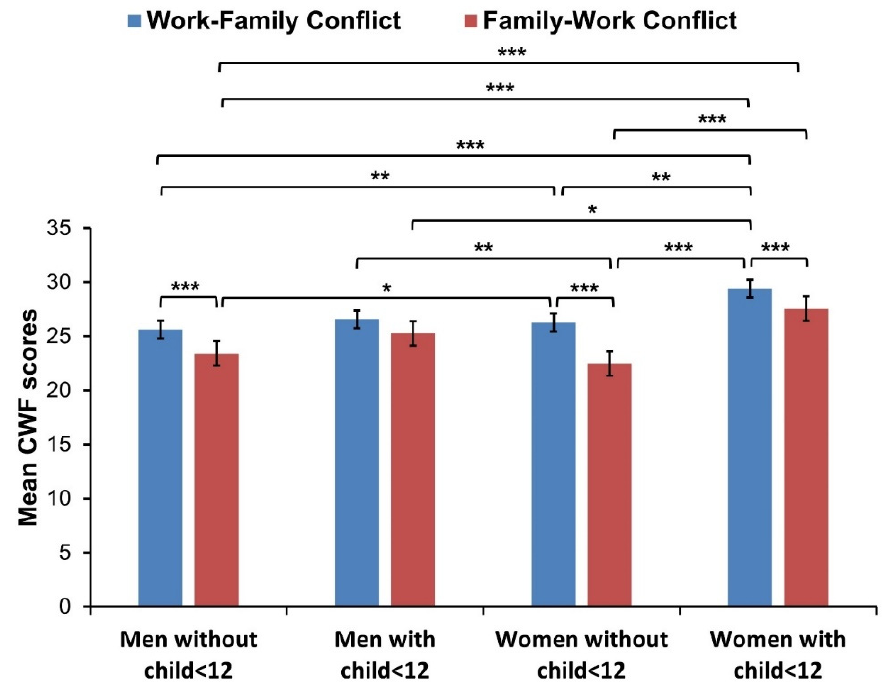
Figure 1. Differences in conflict work-family (CWF) between women and men with and without children under 12. * p < 0.05, ** p < 0.01, *** p < children under 12. * p < 0.05, ** p < 0.01, *** p < 0.001.